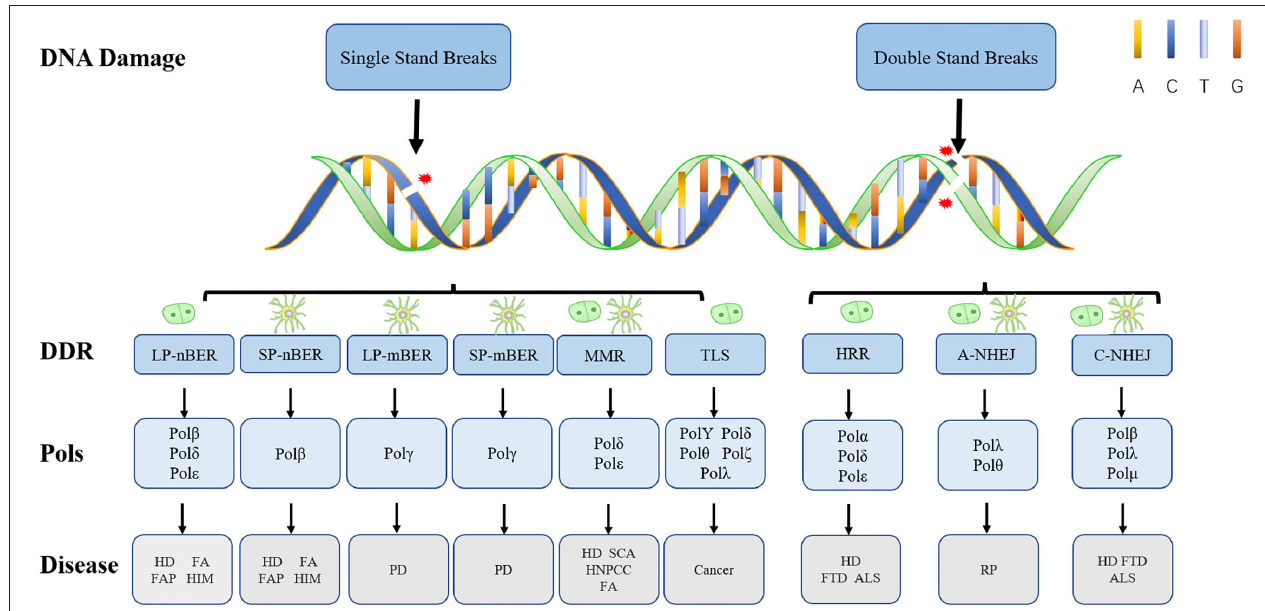
FIGURE 2 | Types of DNA damage and corresponding repair pathways. Endogenous and exogenous factors can induce different types of DNA damage. Here, we show their DDR mechanisms and cell proliferation status. The nerve cell model in the figure represents non-dividing cells, and the other model represents dividing cells. While LP-nBER, TLS and HRR exist in dividing cells, SP-nBER, LP-mBER, and SP-mBER exist in non-dividing cells. By contrast, MMR, A-NHEJ, and C-NHEJ exist not only in non-dividing cells but also in dividing cells. Here also shows DNA Pols related to different DNA damage repair pathways and diseases related to different types of damage. It is worth noting that Pol γ only plays a role in mtBER. ALS, amyotrophic lateral sclerosis; FA, Fanconi syndrome; FAP, familial adenomatous polyposis; FTD, frontotemporal dementia; HD, Huntington’s disease; HIM, hyper-IgM syndrome; HNPCC, hereditary non-polyposis colorectal cancer; PD, Parkinson’s disease; SCA, spinocerebellar